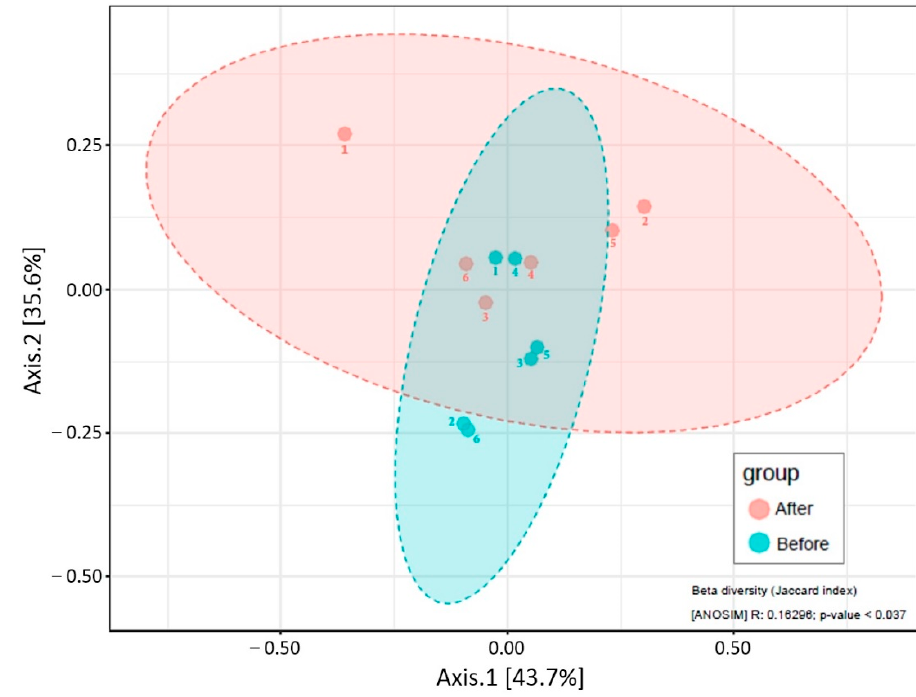
Figure 5. Alpha diversity compared between before and after cleaning the acrylic retainers.